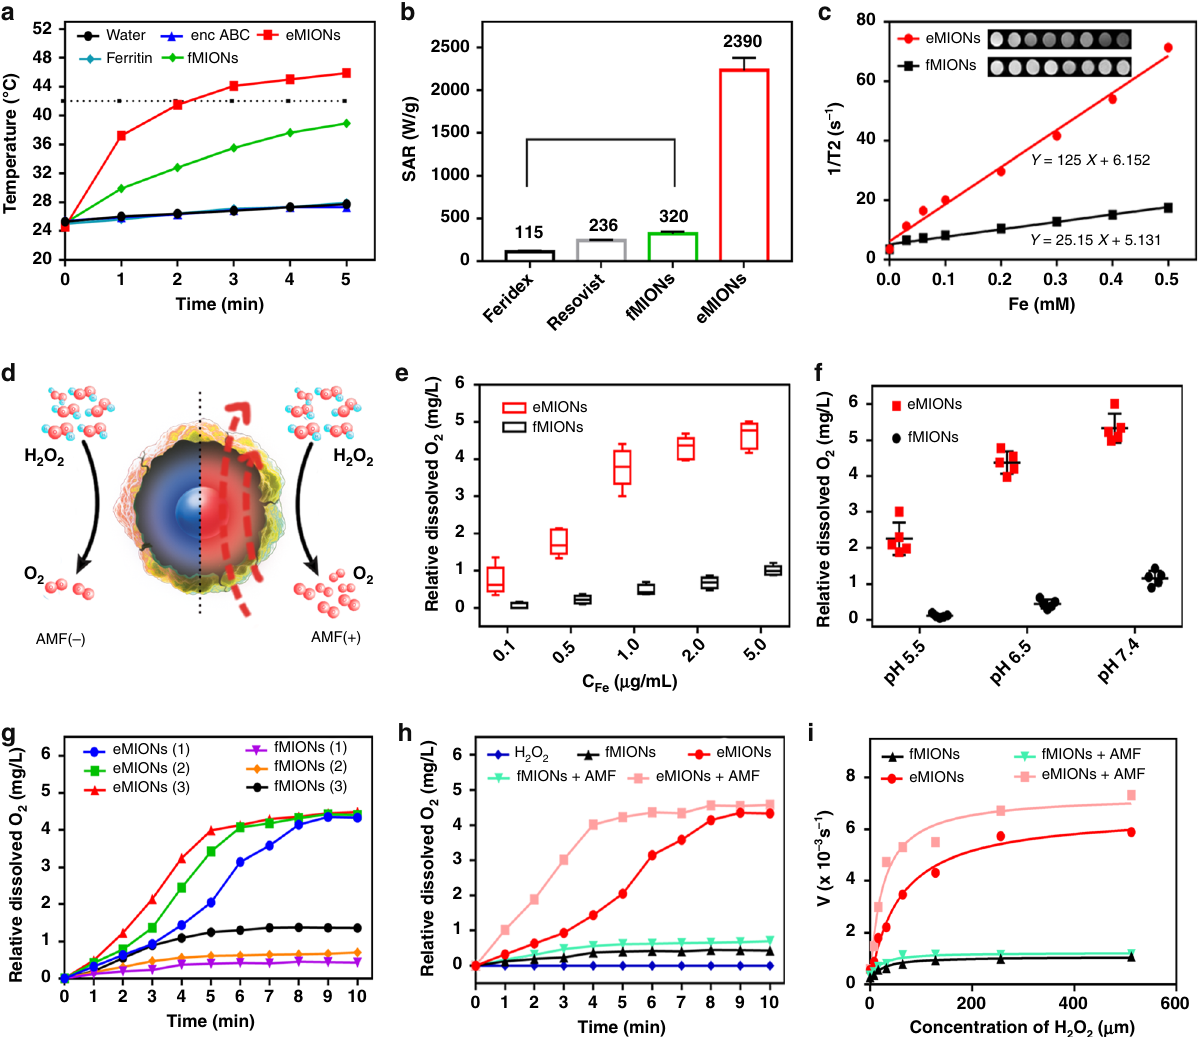
Fig. 3 Functional properties of encapsulin-produced magnetic iron oxide nanocomposites (eMIONs). a Alternative magnetic fi eld (AMF) induced temperature rise. Data are presented as mean ± SD ( n = 5 independent experiments). b Comparison of SAR values of eMIONs to fMIONs and two types of commercial agents. c T 2 -weighted MR images and T 2 relaxation rates (1/ T 2 , s − 1 ) of eMIONs and fMIONs at different iron concentrations. d Schematic illustration of eMIONs for enhancing catalysis under AMF. e – g The relative dissolved O 2 in H 2 O 2 (100 μ M) after incubation of various concentrations of eMIONs and fMIONs ( e , pH 6.8), various pH solutions ( f ), and various temperatures ( g , 1 = 25 °C, 2 = 37 °C, 3 = 43 °C). Data are presented as mean ± SD ( n = 5 independent experiments). Tukey boxplots are shown with the box indicating quartiles and the whiskers drawn at the lowest and highest points within 1.5 interquartile range of the lower and upper quartiles, respectively. Error bars show the 95% con fi dence interval for the difference in proportions or medians between the O 2 production. h , i H 2 O 2 (100 μ M) decomposition by catalase-like activity of eMIONs with oxygen generation measured by the level of dissolved oxygen ( h ) and Michaelis – Menten kinetics ( i ) of eMIONs/fMIONs with/without